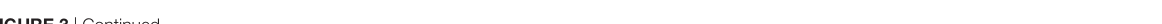
FigUre 3 | Continued Adoptive transfer of chimeric antigen receptor (CAR) regulatory T cells (Tregs) reduces airway hyper-reactivity, inflammation, mucus production, and eosinophilia in mice with induced experimental asthma. (a) Schematic outline of the experimental protocol. (B) Lung resistance (R) after exposure to increasing concentrations of methacholine (MeCh) was recorded as described in Section “Materials and Methods.” Data from n = 9–11 mice from three independent experiments are